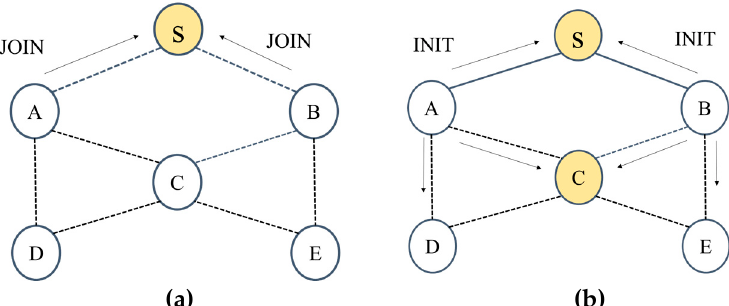
Figure 4. Packet collisions during the NCP. ( a ) Collision between JOIN packets, ( b ) Collision between INIT packets.